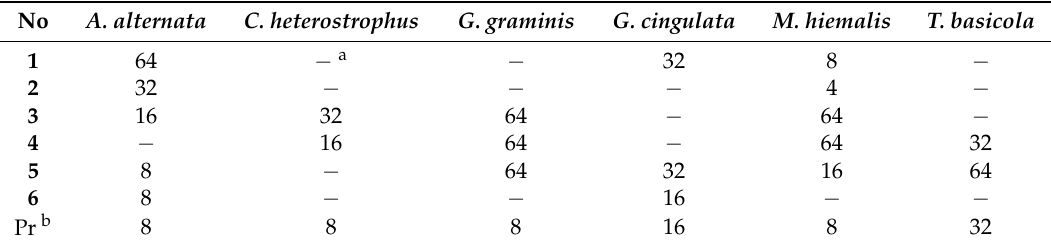
Table 2. MIC value of compounds 1 – 6 against plant-pathogenic fungi ( µ